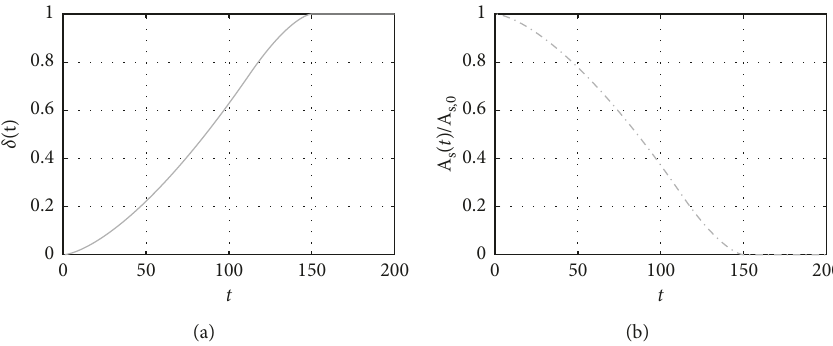
with time expressed in years s